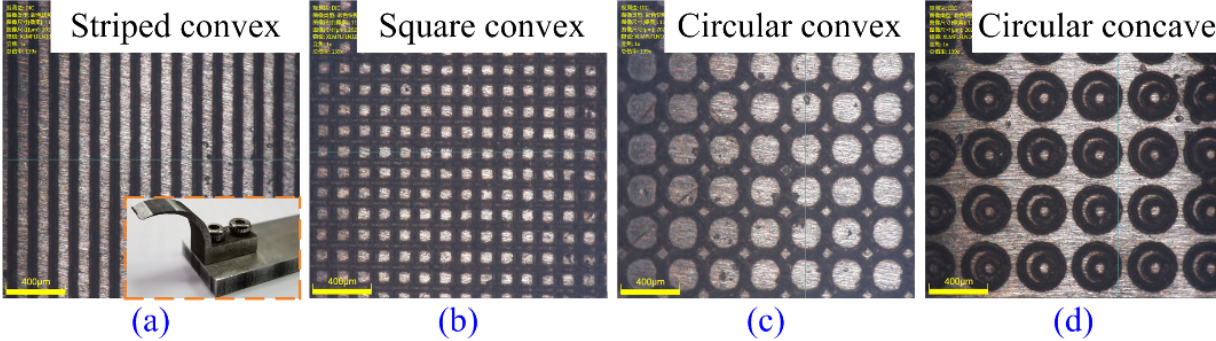
Figure 4. Four kinds of microstructures fabricated on the driving feet surfaces by laser texturing: ( a ) striped convex, ( b ) square convex, ( c ) circular convex and ( d ) circular concave.